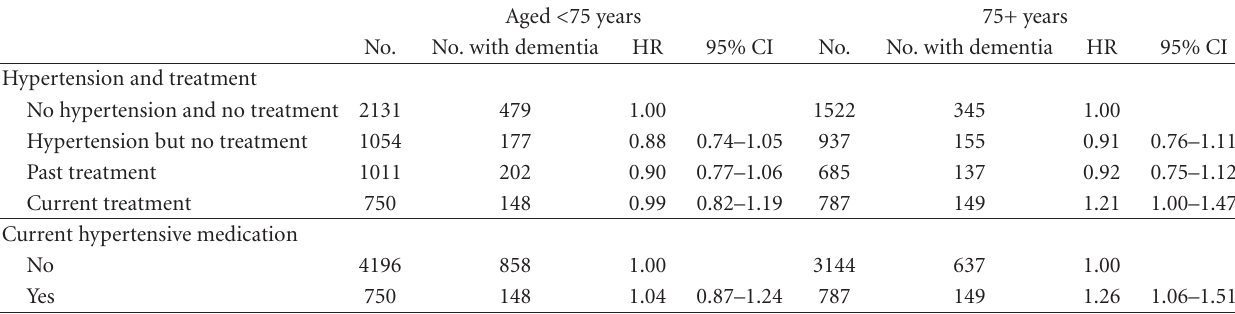
Table 3: Hazard ratios for dementia by hypertension and its treatment in women, Leisure World Cohort Study,